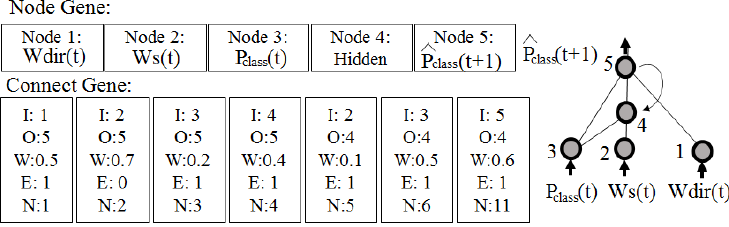
Figure 6. Encoding of an NN with 1 output and 3